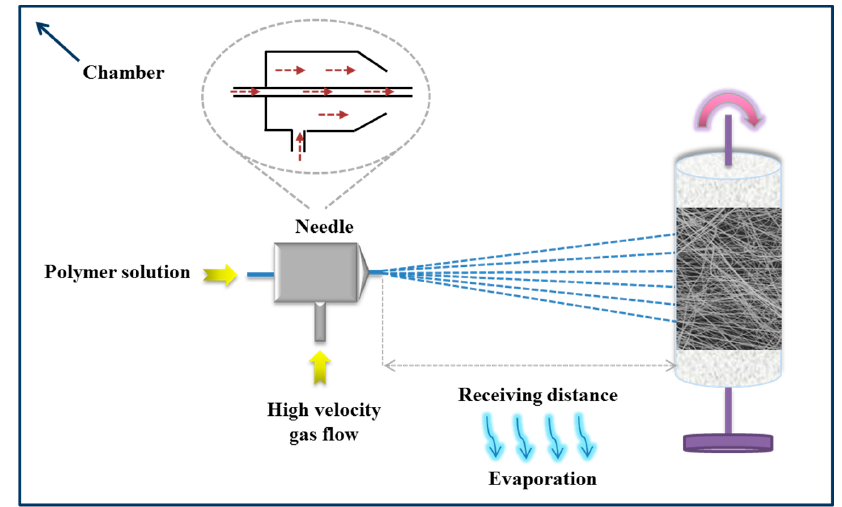
Figure 10. The schematic of self-made SBS apparatus.